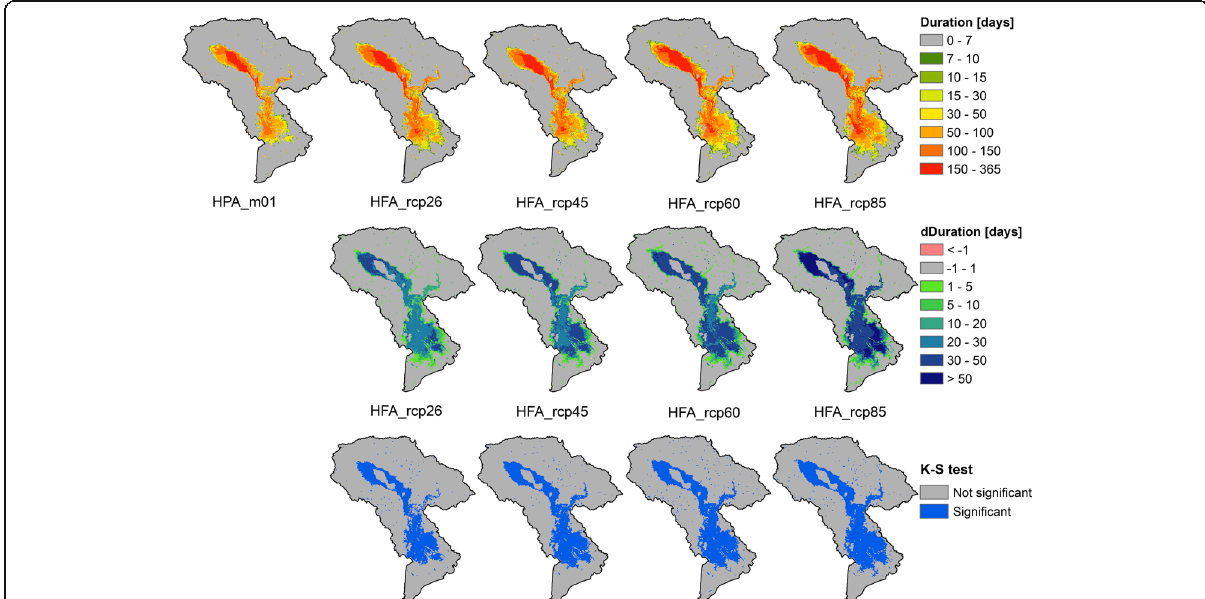
Fig. 11 Spatial distribution of inundation duration (upper row), difference between present and future RCP scenarios (middle row), and K-S test (lower row) for MRI-AGCM3.2H